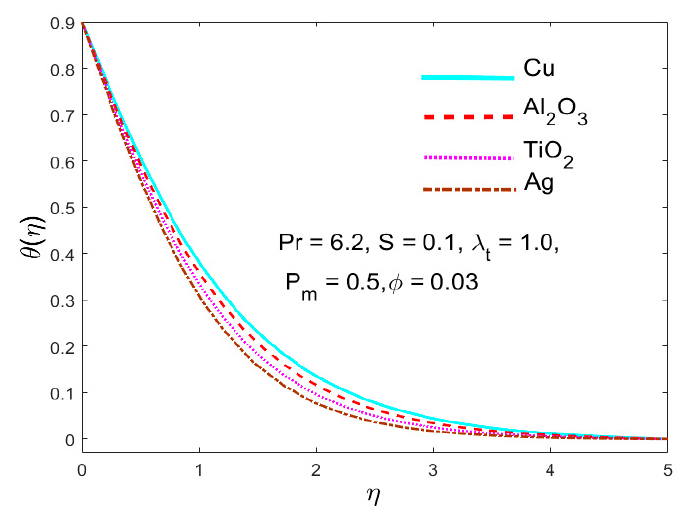
( ) θ η . Figure 12. E ff ect of di ff erent nanoparticles on θ ( η ) .